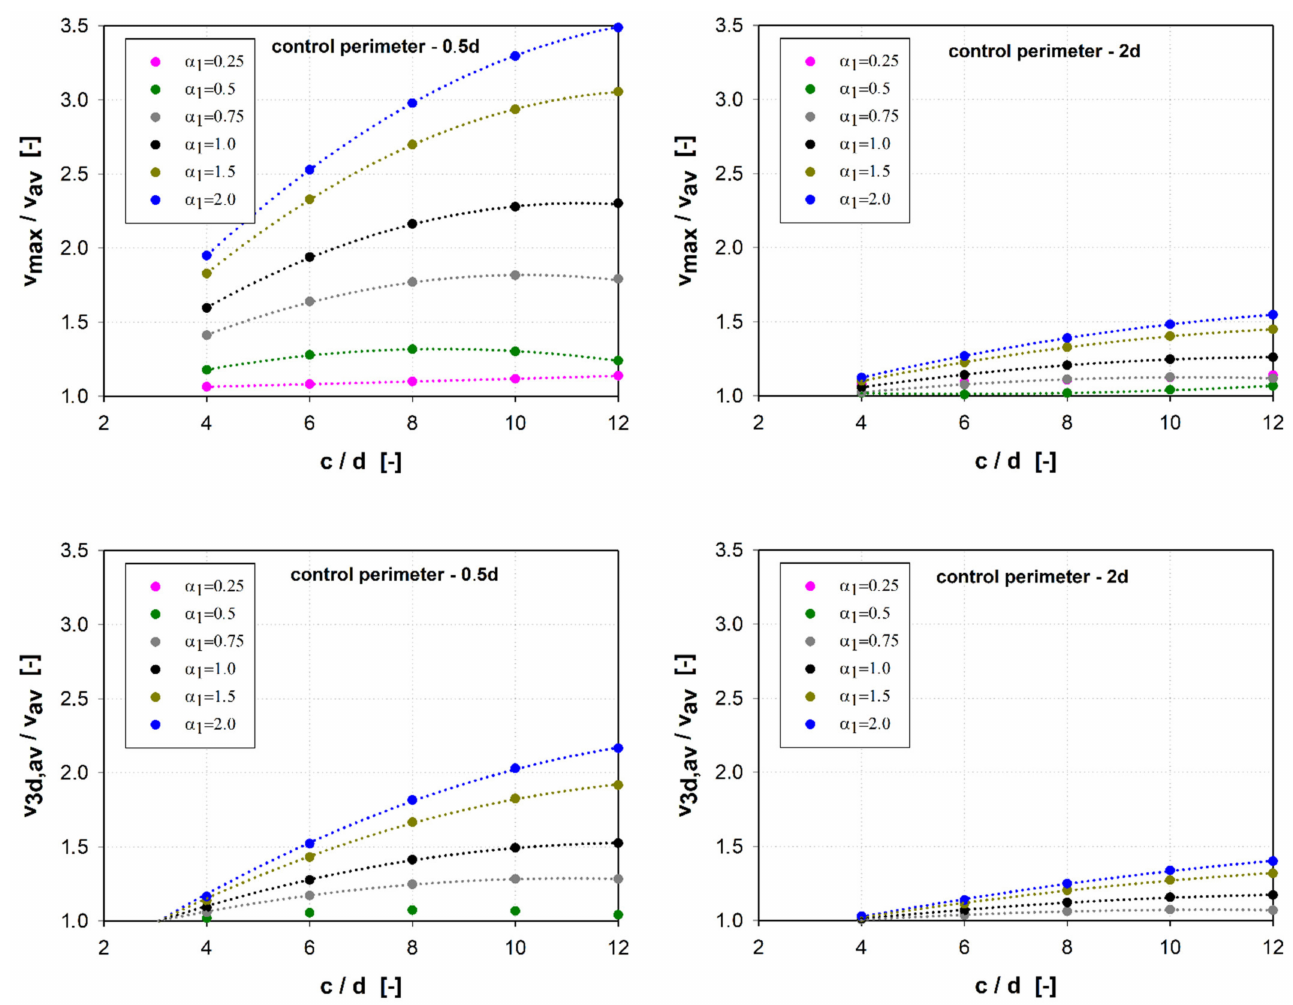
Figure 9. Influence of the shear cap size and its stiffness on the shear force distribution in the control perimeter located at a distance of 0.5 d and 2 d from the face of the shear